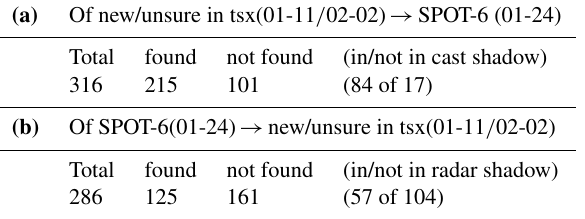
Table 3. (a) Number of avalanches in TSX change detection image compared to avalanches which were also detected in the optical SPOT-6 data. (b) Reverse correspondence of avalanches from SPOT-6 to new and unsure avalanches detected by radar. Avalanches which were not found are grouped depending on their location in the cast shadow (a) or in the radar shadow (b) .